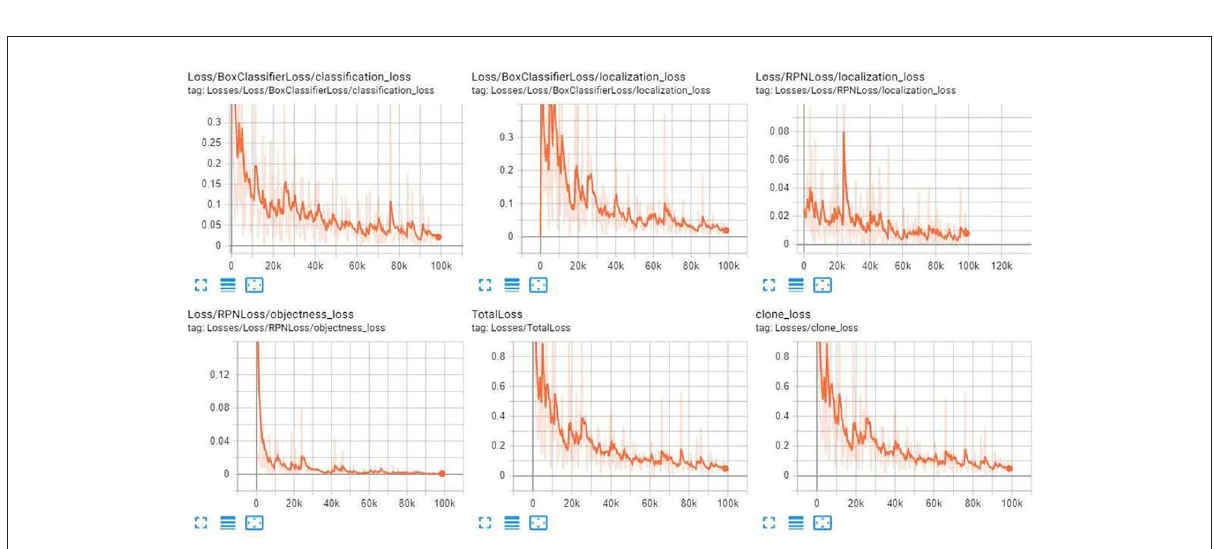
FIGURE9 Kitti-Trained models (ResNet101) training Loss